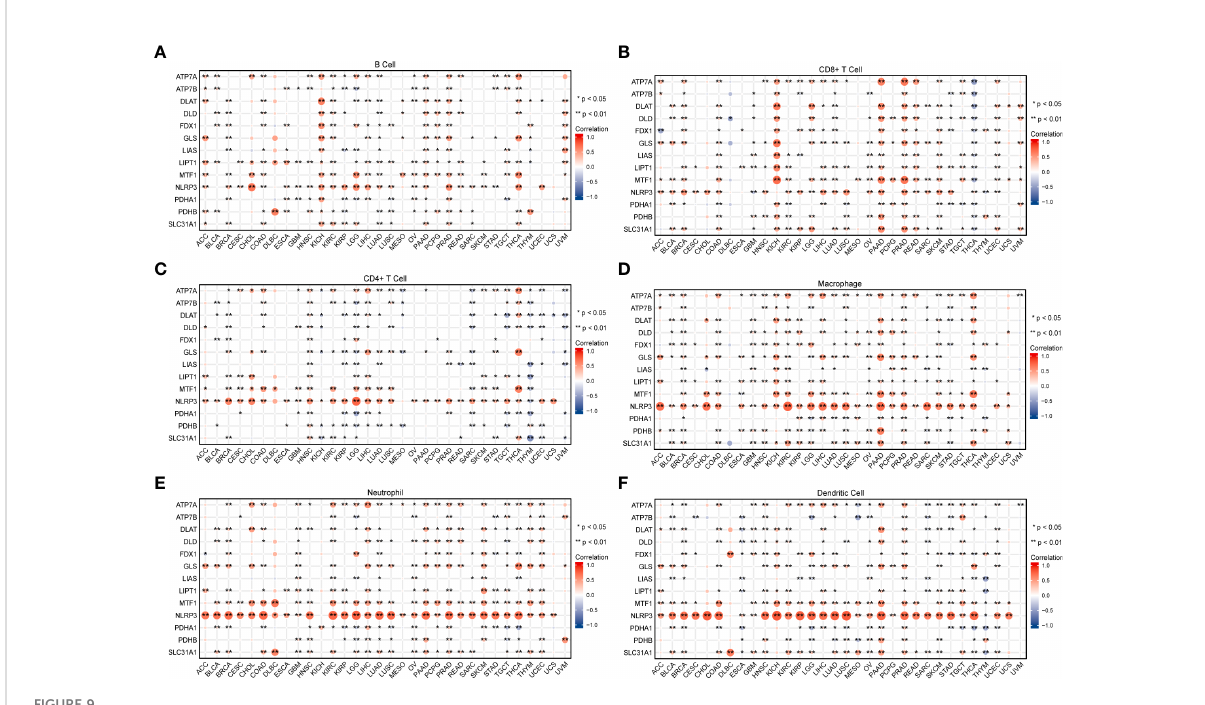
FIGURE 9 The relationship between the expression of cuproptosis-related genes and in fi ltrating levels of B cells (A) , CD8+ T cells (B) , CD4+ T cells (C) , macrophages (D) , neutrophils (E) , and dendritic cells (F) in pan-cancer was analyzed using the TIMER database (*P < 0.05; **P < 0.01).